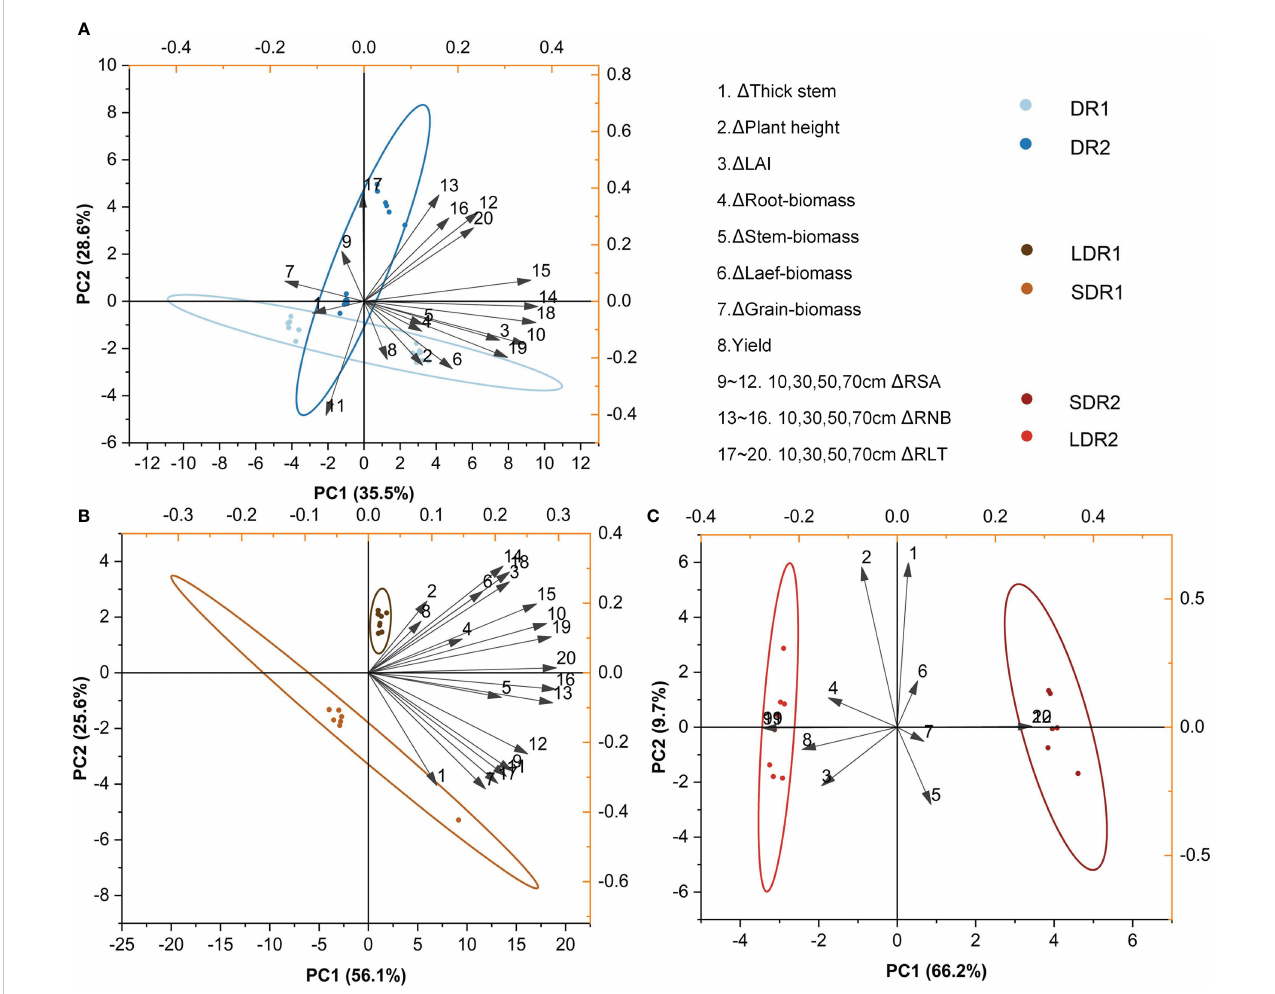
FIGURE 8 PCA analysis of the effects of different (A) drought degrees and (B) drought durations under light drought stress and (C) drought durations under moderate drought stress on various growth indexes of summer maize in the T4